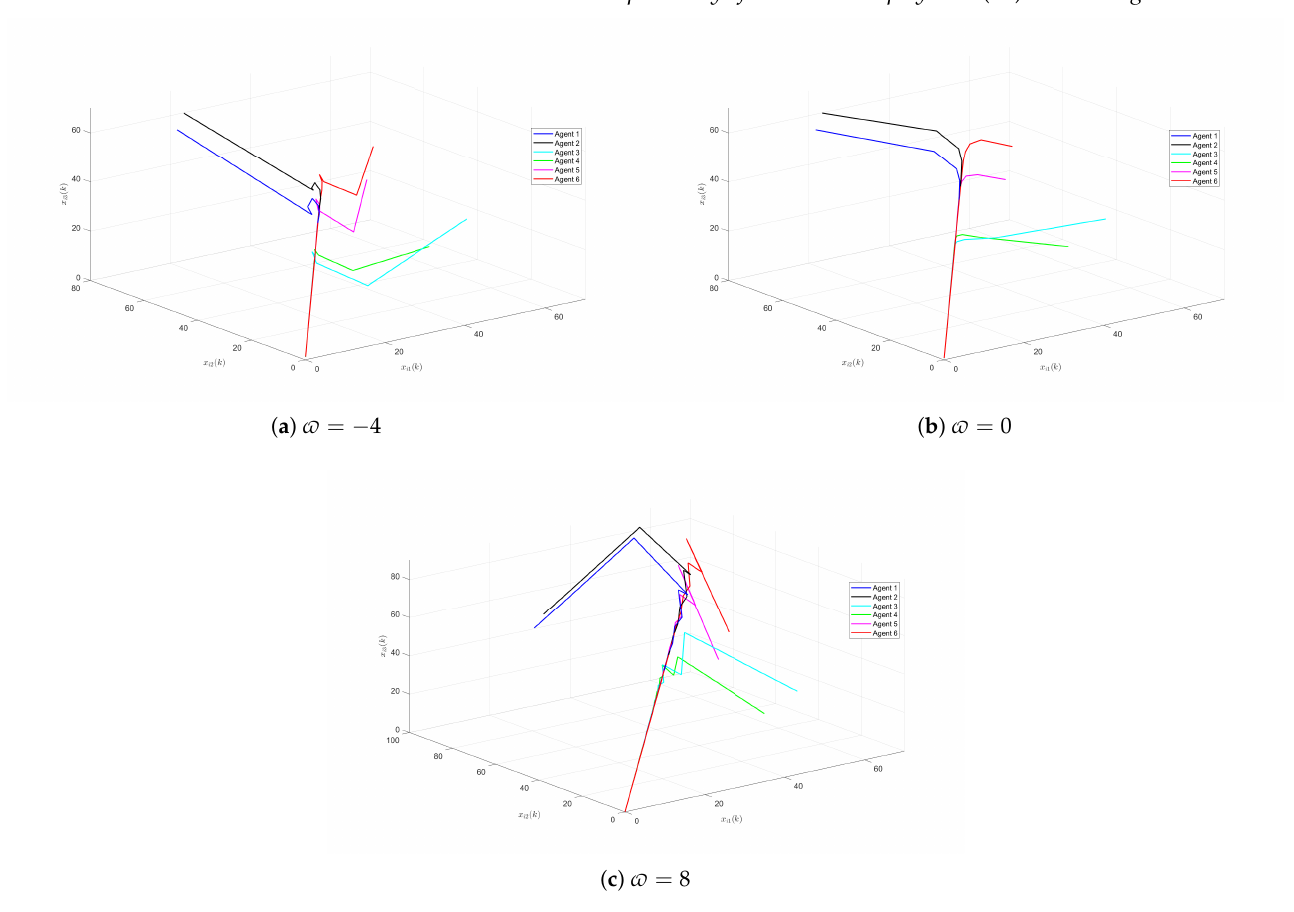
Figure 14. The state trajectory of all the agents with different disturbances of component D